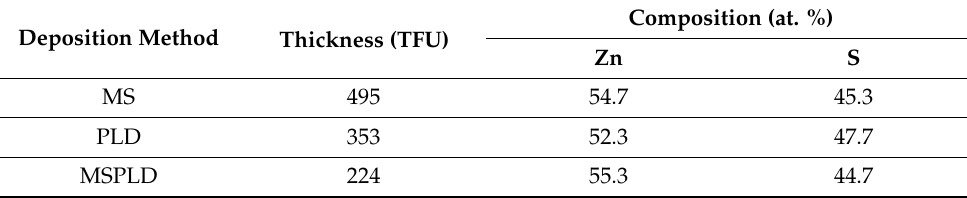
Table 1. RBS composition of the ZnS thin